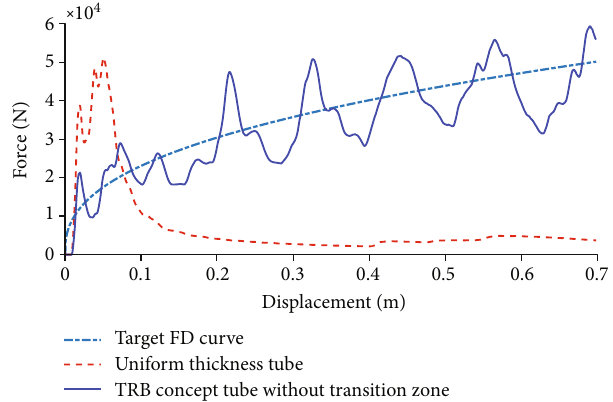
Figure 27: The FD curve of the uniform thickness tube and the TRB concept tube without transition zone.